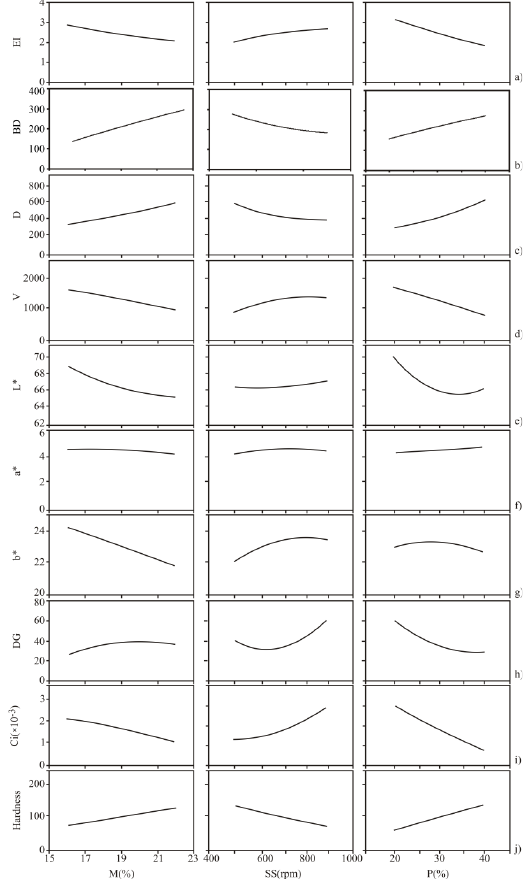
Figure 2. Effect of extrusion process parameters (M — moisture content, %; SS — screw speed, rpm; P — chicory root flour content, %) on investigated parameters (EI — expansion index, BD — bulk density, D — extrudate ′ s density, V — extrudates ′ s volume, L* — extrudates ′ s lightness, a* — extrudate ′ s redness/greenness, b* — extrudate ′ s yellowness/blueness, DG — degree od gelatinization, Ci — crispiness index) ( a – j )by ANN.